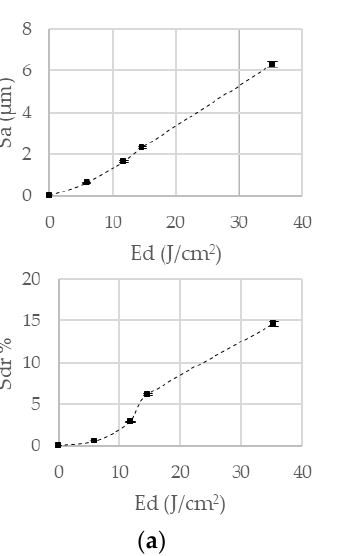
Figure 3. Surface roughness parameters: ( a ) At different Ed at fixed Vs = 10 mm/s; ( b ) At different Vs at fixed Ed = 35.37 J/cm 2 .